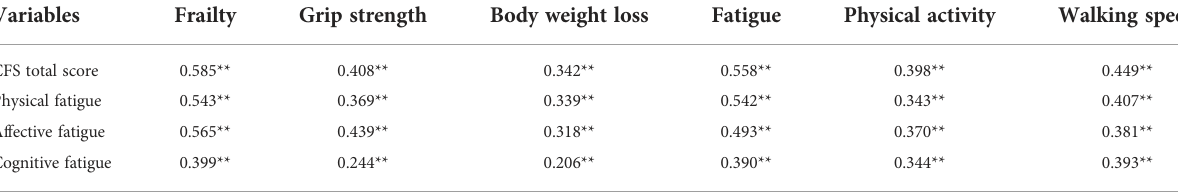
TABLE 4 Correlation analysis among frailty and fatigue (N = 302).